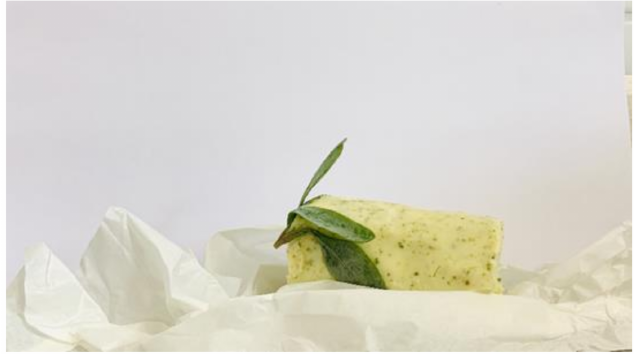
Figure 7. Butter enriched with H. portulacoides